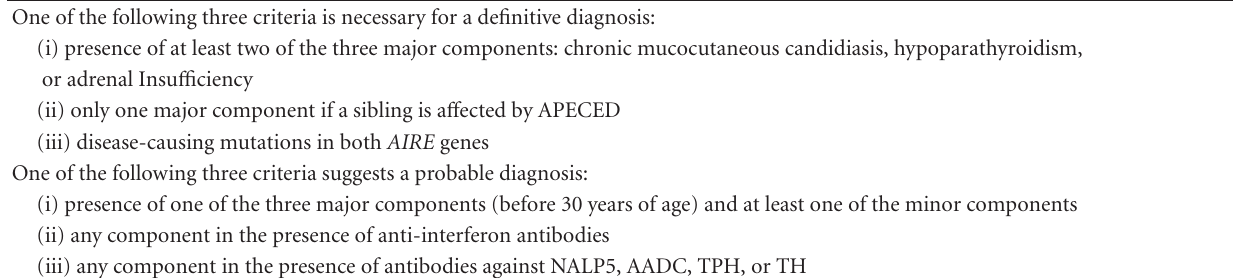
Table 2: New diagnostic criteria for the diagnosis of APECED as reported by Husebye et al.